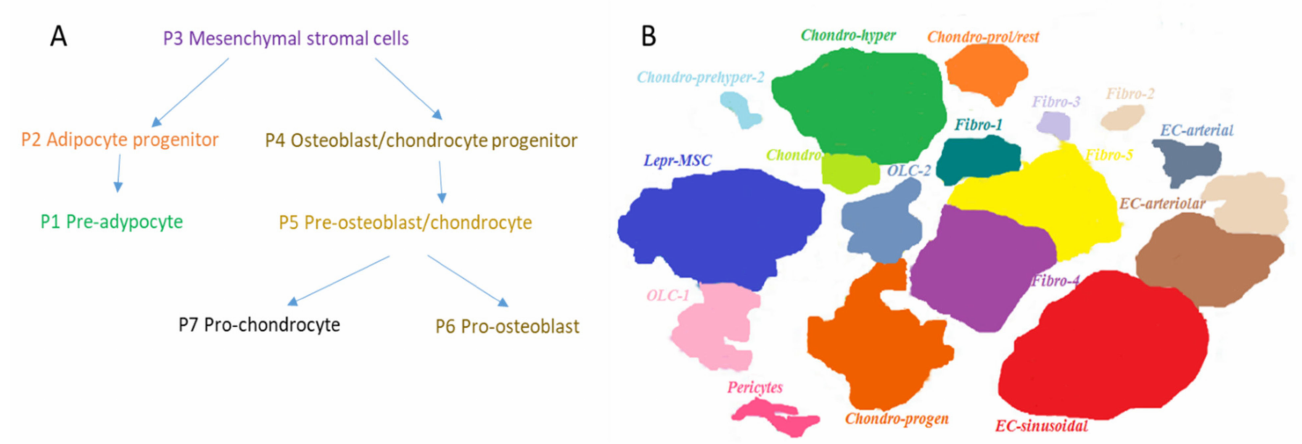
Figure 3. Population structure of the mouse BM stroma compartment identified by single-cell transcriptome analysis: ( A ) distinct BM niche populations and their differentiation paths revealed by SPRING plot of single-cell transcriptomes, adapted from [90]; ( B ) cellular taxonomy of BM stroma and seventeen BM stroma cell clusters identified by t-Distributed stochastic neighbor embedding (t-SNE), adapted from [92]. Colors indicate graph-based cluster